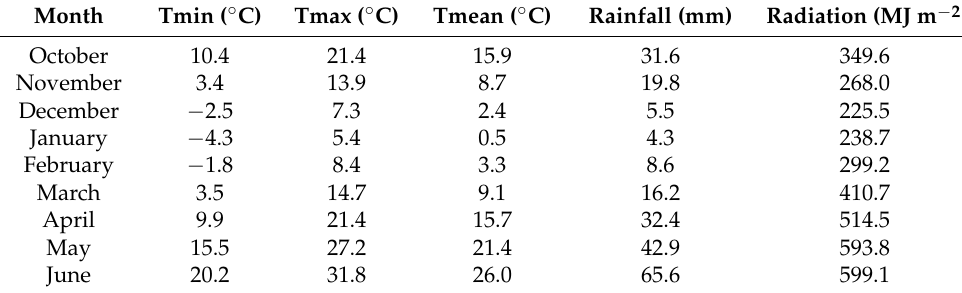
Table 2. Average climatic characteristics of the study area.